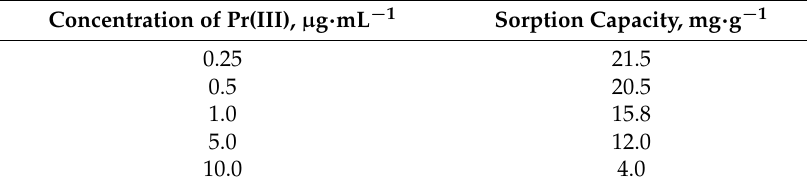
Table 1. Dependence of the sorption capacity of clinoptilolite on concentration of Pr(III), pH 9.0.